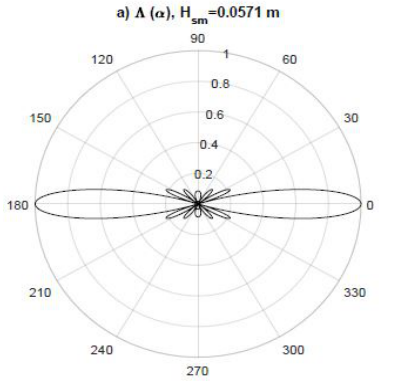
Figure 8. Beam pattern of the experimental SMP.